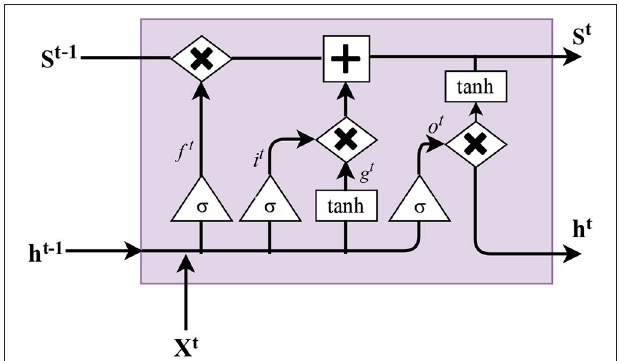
FIGURE 4 | LSTM memory cell. Inputs: current input x t , state of previous time step S t − 1 and output of previous time step h t − 1 . Outputs: updated state S t and current output h t